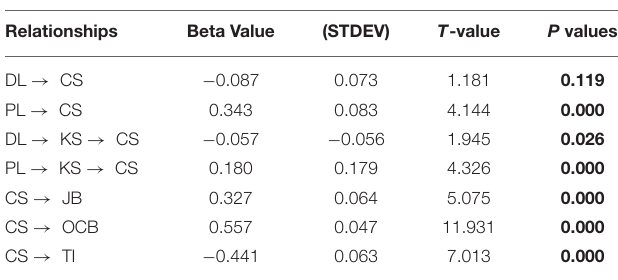
TABLE 3 | Structural